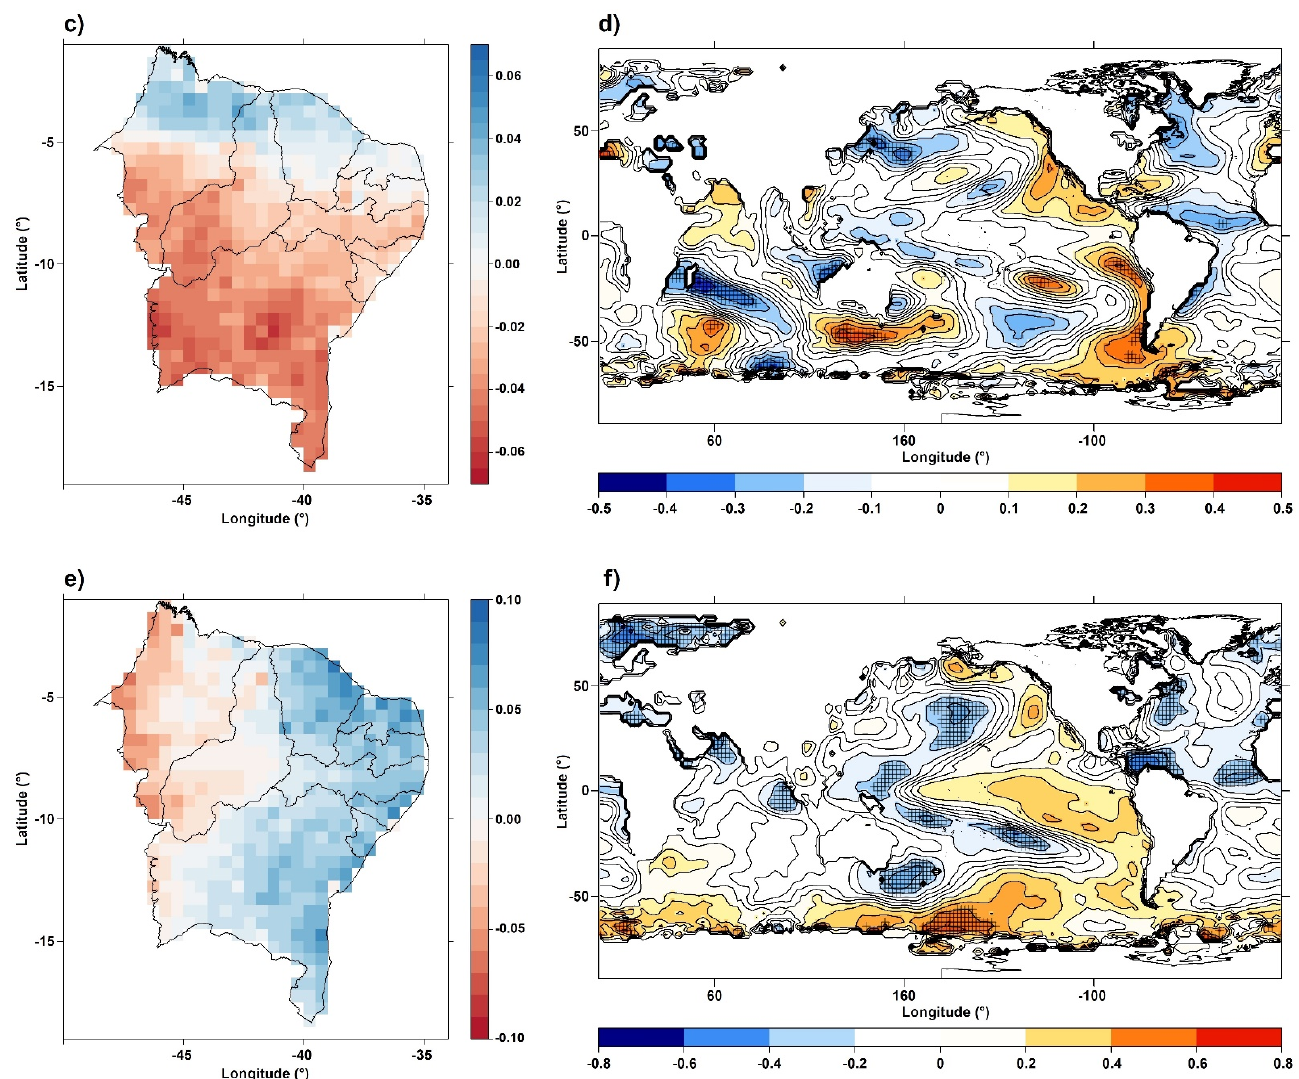
Figure 5. The EOF loading pattern of the first, second and third leading modes obtained from their FMA precipitation ( a , c , e , respectively) and their corresponding December SST correlation fields ( b , d , f, respectively). The points on the map represent statistical significance at the 5% level using the student’s t